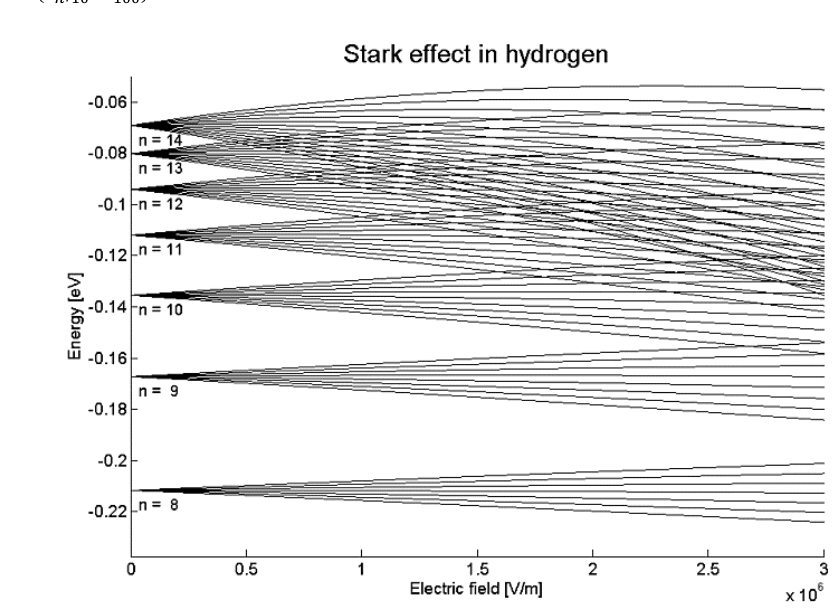
Figure 2. The Stark effect shows the splitting of lines in Hydrogen atom.